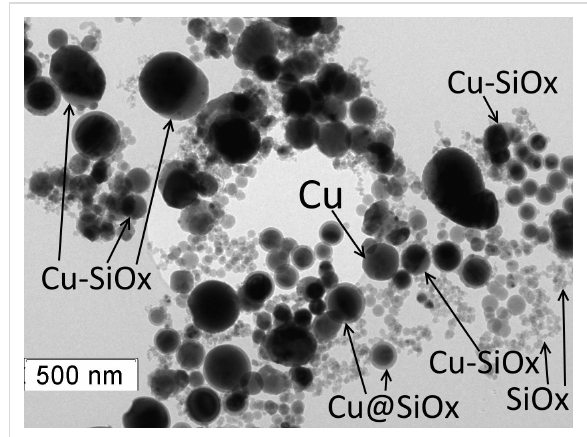
Figure 6: Transmission electron microscopy of the Cu–SiO x Janus- like, Cu@SiO x core–shell, pure Cu and SiO x nanoparticles (1 < x < 2).